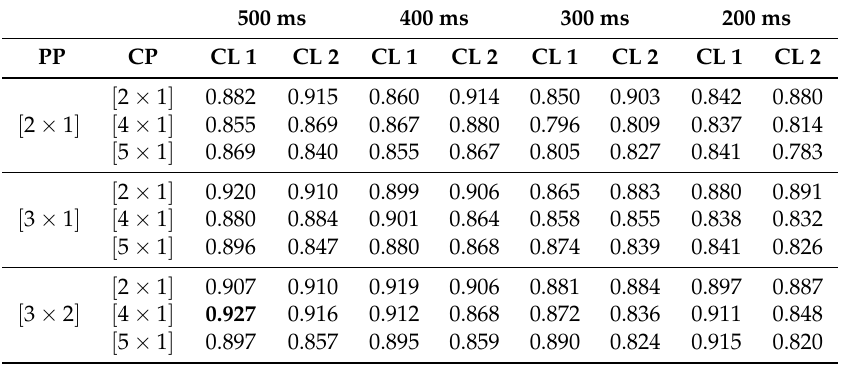
Table 3. Summarized results for the 18 CNN structures for all considered trial lengths with fixed pool patches. PP = pool patch, CP= convolution patch, CL= convolution